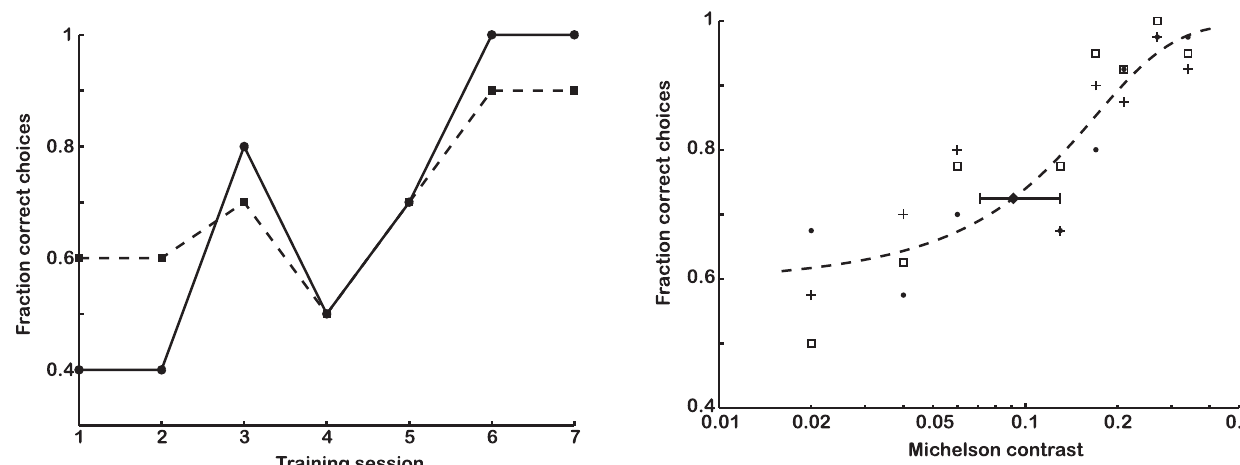
Figure 1. A learning curve for brightness discrimination in one budgerigar. Two stimulus pairs were used in training, one pair with a 0.38 (solid line with filled circles) and one pair with 0.18 Michelson contrast (dashed line with filled squares). In each training session, the stimulus pairs were presented 10 times each in a mixed random order. This bird qualified for testing by fulfilling the criterion of having correct choice frequencies of at least 80% for both stimulus pairs in two consecutive sessions (session 6 and 7 in this example). All birds completed training within 7 sessions.